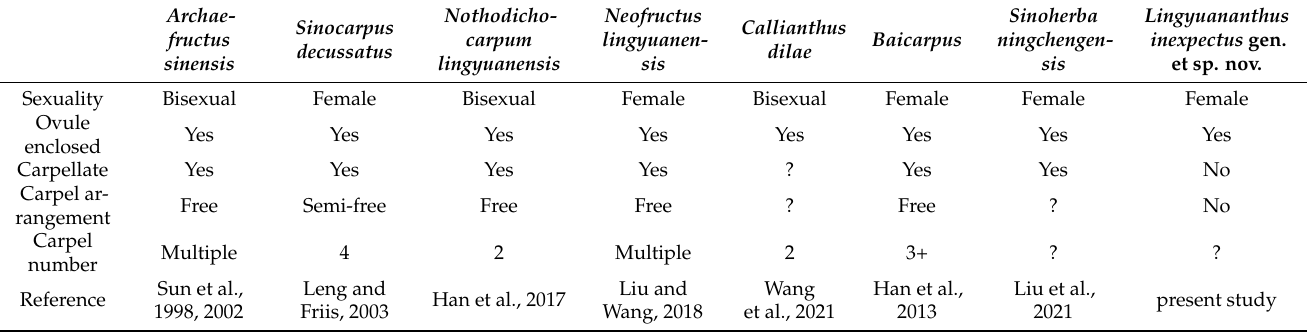
Table 1. Comparison between Lingyuananthus inexpectus gen. et sp. nov. and other angiosperms from the Yixian